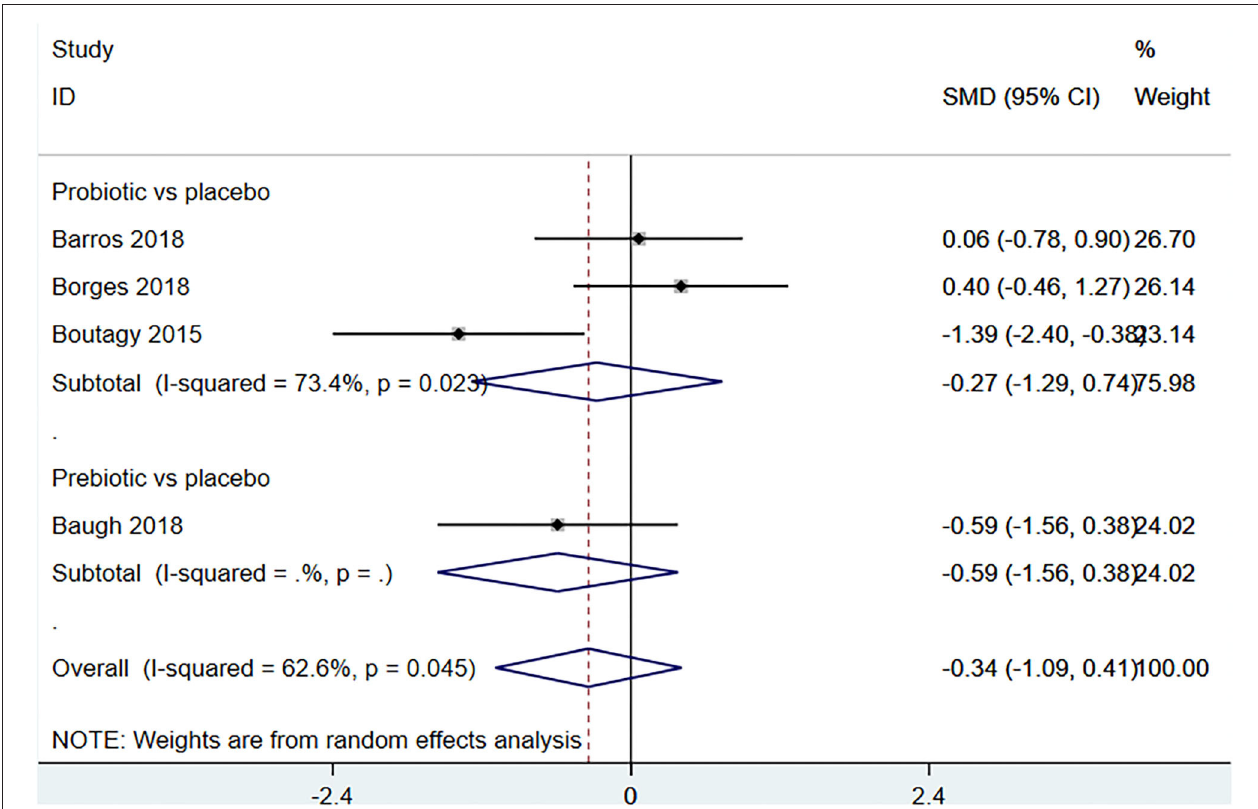
FIGURE 8 | Forest plot for the effect of microbiota-driven therapy on circulating choline level (subgroup analysis). The effect size of each trial or the overall was represented as black diamond and the weight of each trail in the overall study was represented as gray box around black diamond. The estimated 95% confidence interval of effect size was identified by extending lines. CI, confidence interval; RCT, randomized controlled trial; SMD, Standard Mean